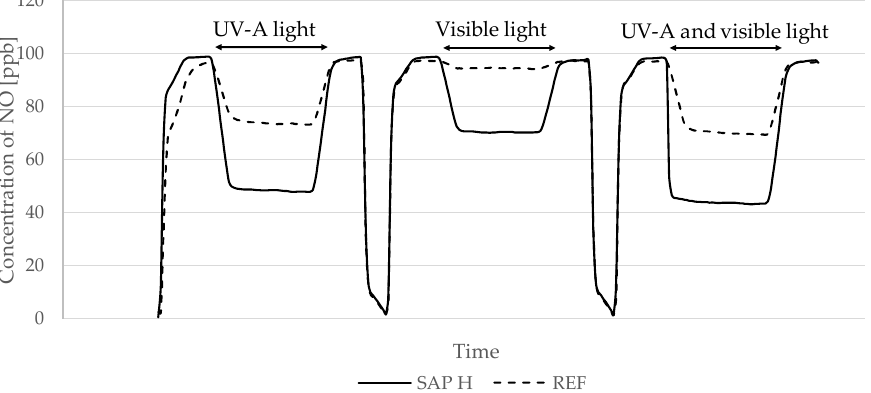
Figure 4. The efficiency of air purification from NO pollutants on a mortar sample formed in a mold with a layer of SAP hydrogel covered in TiO2 dispersion (SAP H) and reference series with no surface modification (REF). The test consisted of three parts: the study of the phenomenon of photocatalysis in UV-A light (first decrease in NO concentration), in visible light (second decrease in NO concentration), and in combined UV-A + visible light (third decrease in NO concentration). [ppb]— parts per billion, 10-9. Table 4. Relative reductions in NO concentrations in performed tests for all considered surface mod- ification techniques.